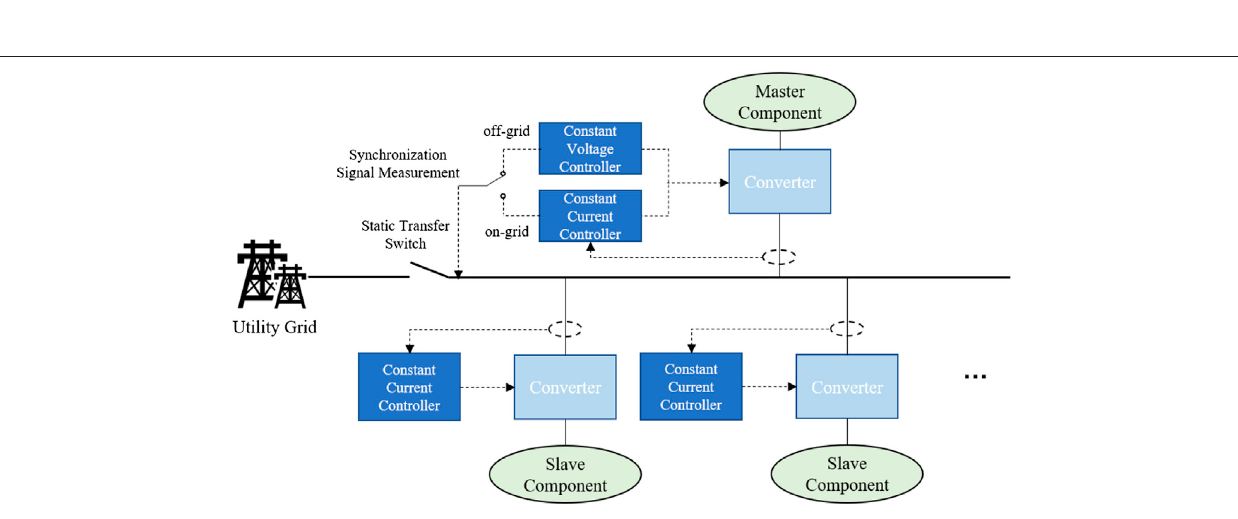
FIGURE 4 | Structure of the Master-slave